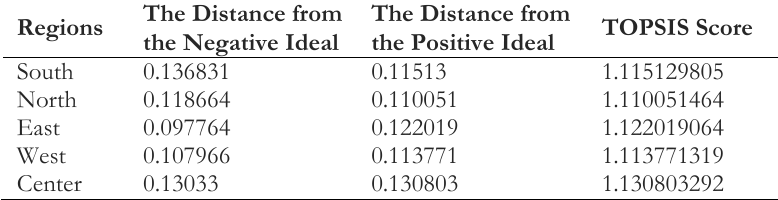
Table 8. The results of the TOPSIS